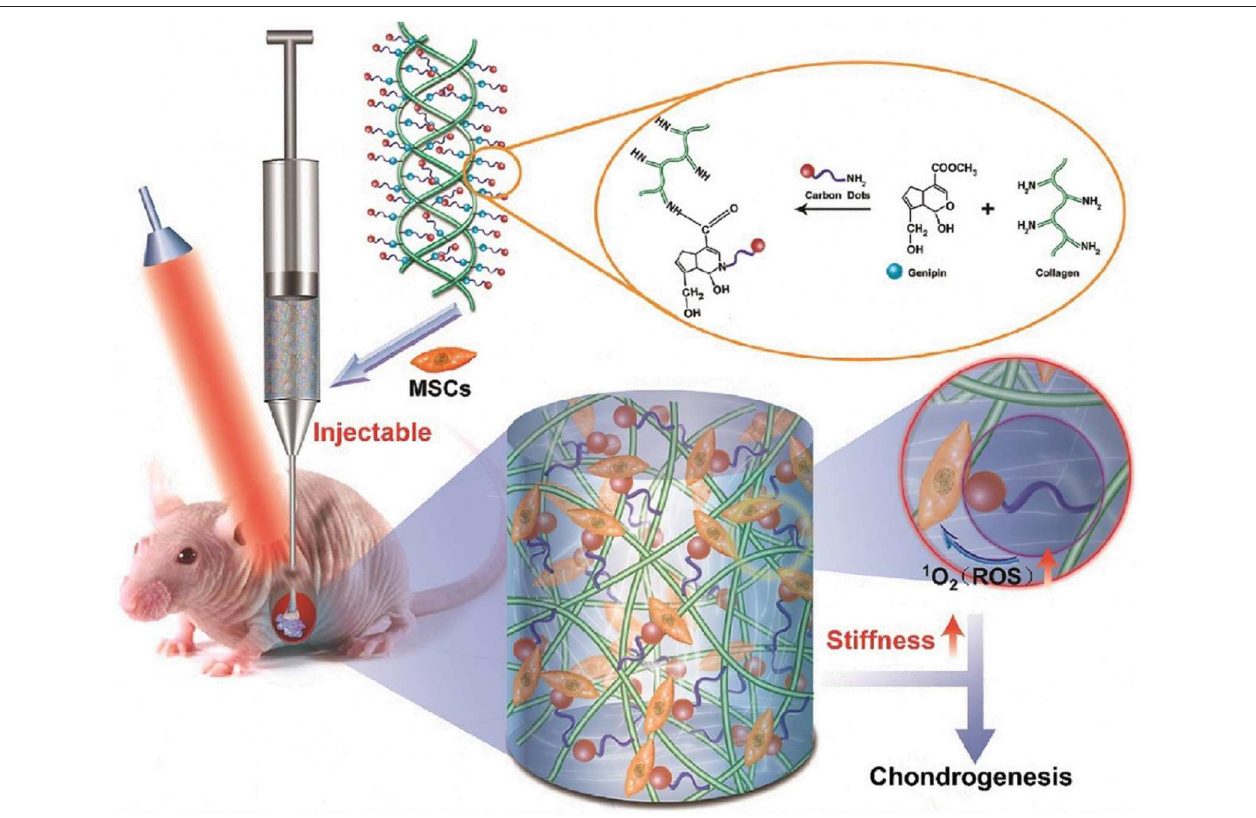
FIGURE 7 | Schematic illustration of the fabrication process and implementation of CGN nanocomposite hydrogels. Reproduced from Lu et al. (2019) with permission from Copyright 2019 Elsevier.